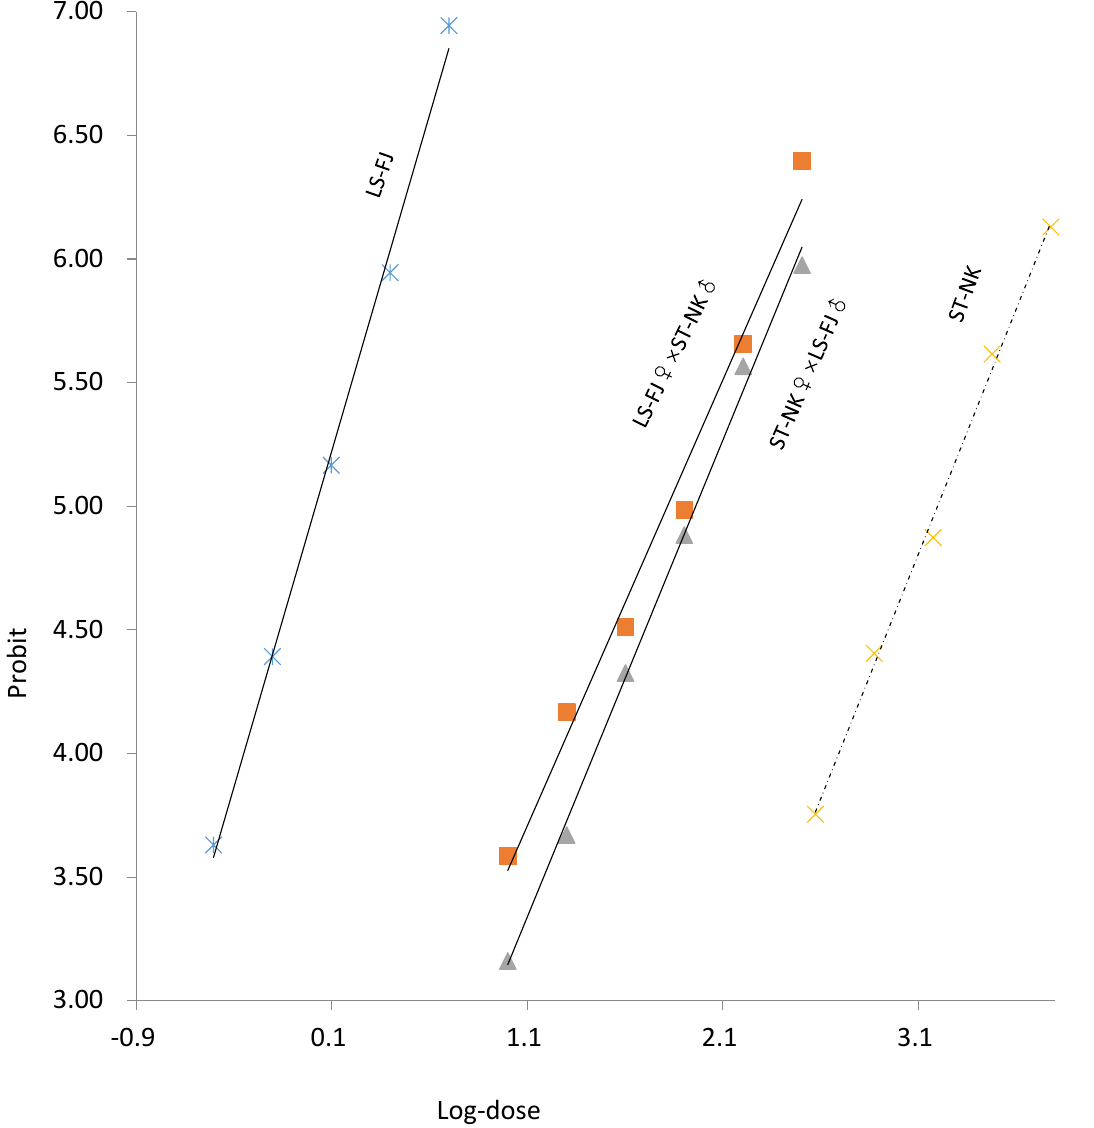
Figure 3. Spirotetramat concentration-mortality curves for LS-FJ, ST-NJ, and reciprocal crosses. The log dose/probit mortality lines of spirotetramat for the backcrosses, corrected for haploid male offspring, are presented in Figure 4. The lines exhibit an absence of a plateau at 50% level or at the 75% level. On the other hand, data from the chi-squared analyses for the (LS-FJ × ST-NK) ♀ × LS-FJ ♂ and (ST-NK × LS-FJ) ♀ × ST-NK ♂ (F2) were highly significant (χ 2 = 98.85, df = 18 and χ 2 = 249.82, df = 20, respectively, p < 0.001). Generally, large values of the χ 2 statistic are considered to be an indication that the assumptions made about the mode of inheritance (in this case, one major gene mode) are wrong, so these results also seem to support the inheritance of multiple genes.